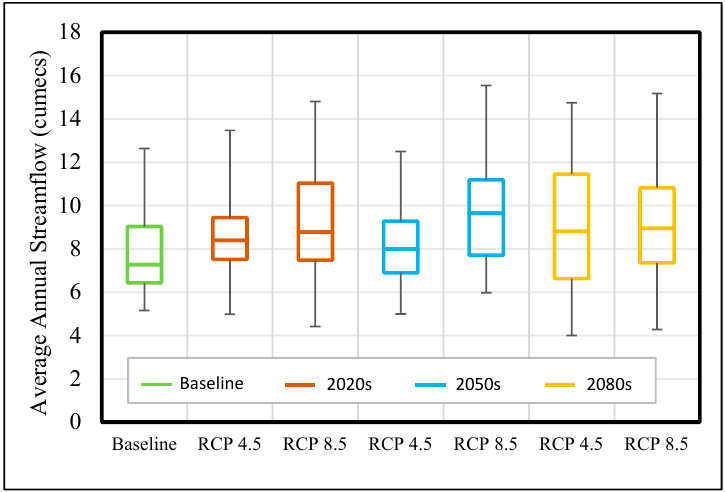
Figure 9. Box and whisker plot for average annual streamflows under RCP 4.5 and RCP 8.5.